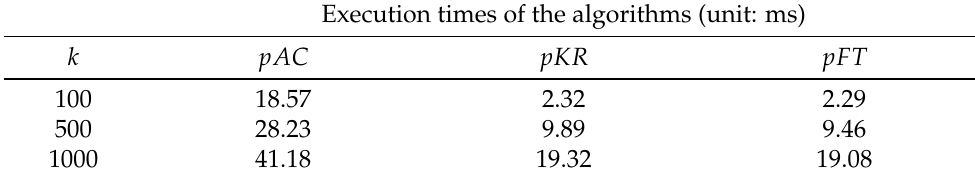
(b) Comparison of execution times varying k when n = 100,000, m = 10 Execution times of the algorithms (unit: ms)